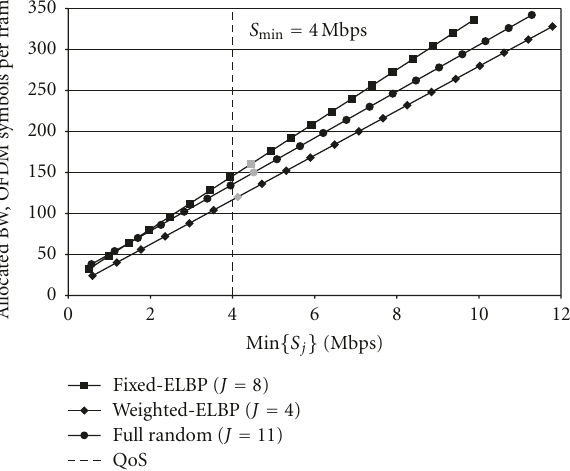
Figure 12: Allocated bandwidth versus